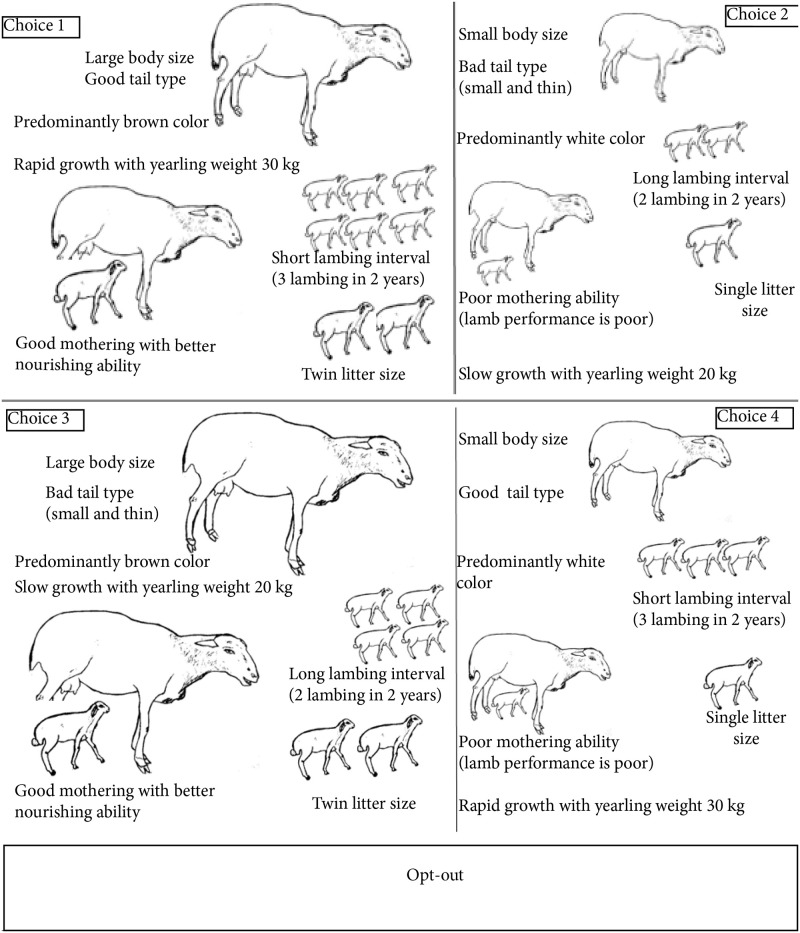
Sample choice card for ewe attribute levels.